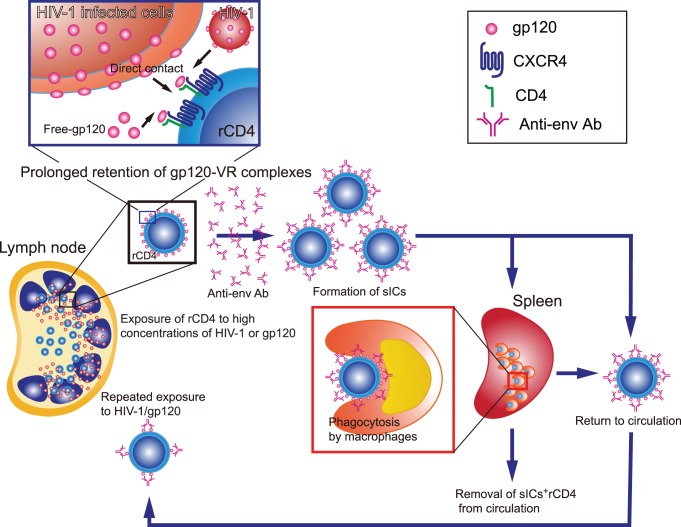
Schematic figure summarizes the causes and consequences of sIC+ rCD4s.rCD4s continuously travel between the blood stream and LNs over a period of approximately 1 d. Because a large proportion of HIV-1 is produced in the LNs, the target T cells that migrate to the LNs are exposed to high concentrations of HIV-1, gp120, or ICs as well as anti-env Abs. Prolonged retention of gp120-VR complexes on rCD4s causes the retention of sICs in a manner that reflects the levels of HIV-1 exposure in the LNs. sIC+ rCD4s are removed from circulation through ADCP or ADCC by macrophages or NK cells, respectively. The sIC+ rCD4s that are not removed from circulation remigrate to the LNs to be exposed to a high concentration of gp120/HIV-1. The percentages and amounts of sICs on rCD4s in the blood reflect a balance of five factors, namely, the levels of virus production in lymphoid tissues, the levels of anti-env Abs, the turnover dynamics of sICs on rCD4s, the duration of repeated exposure by continuous migration to the lymphoid organs, and the levels of immunological elimination of sIC+ rCD4s.